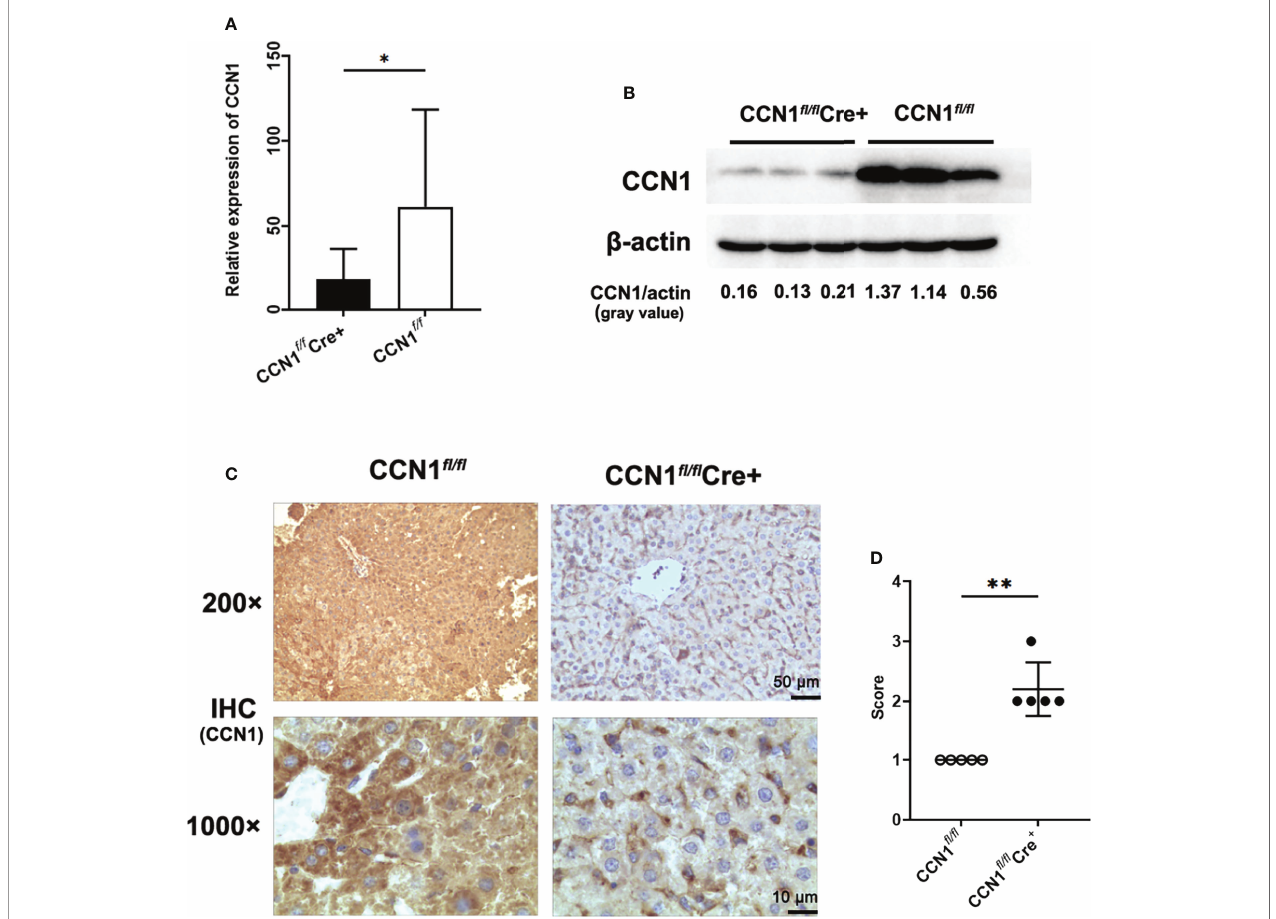
FIGURE 4 | Construction and identi fi cation of CCN1 conditional knock out mice. (A) mRNA expression of CCN1 in hepatocytes of CCN1 fl / fl Cre + and CCN1 fl / fl mice determined by real-time PCR. (B) CCN1 protein level in hepatocytes of CCN1 fl / fl Cre + and CCN1 fl / fl mice detected by Western blot. The relative expression of CCN1 protein was expressed by gray value. (C) IHC staining images of CCN1 in liver tissues from CCN1 fl / fl Cre + and CCN1 fl / fl mice. Original magni fi cation ×200 (upper, scale bar: 50 µm), ×1000 (bottom, scale bar: 10 µm). (D) Quanti fi cation of IHC staining for CCN1 in mice liver using IHC pro fi ler. The IHC score was expressed as described in methods section. Original magni fi cation ×200 (upper), ×1000 (bottom). *p<0.05,